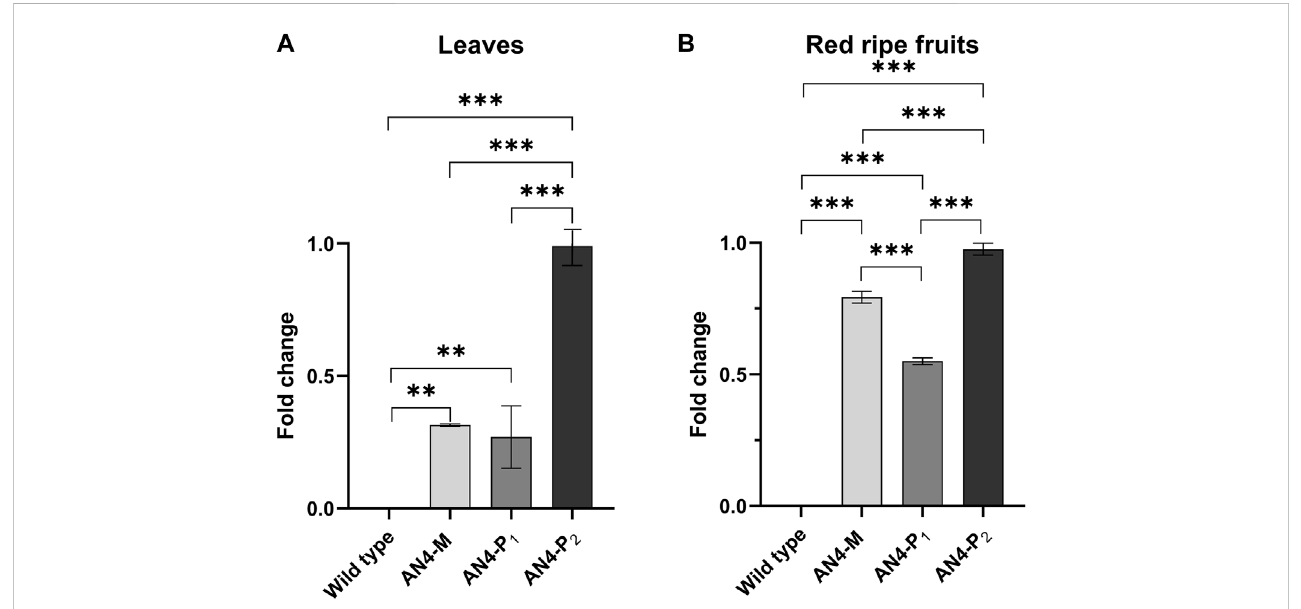
FIGURE 1 PhAN4 gene expression analysisconductedon red ripe fruits (A) and leaves (B) of wildtype, AN4-Mand AN4-P plants. Statistical relevance:*: p < .05; **: p < .001; ***: p <